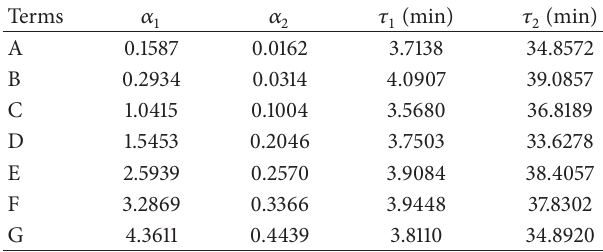
Table 3: Calculated constants for the DIN luminescence standard for different grades from A to G, where the luminous intensity increases as the grade number goes from A to G. A double exponential equation was used for interpretation.